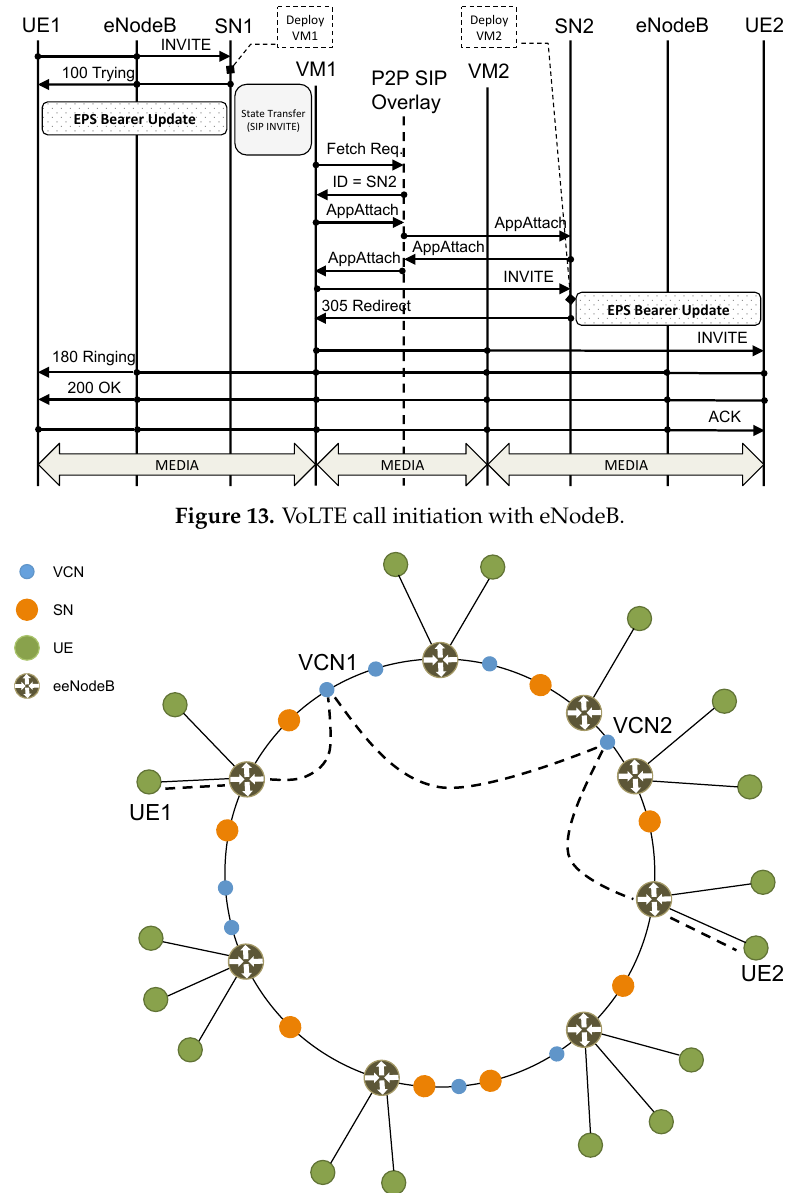
Figure 14. Data path after discovery